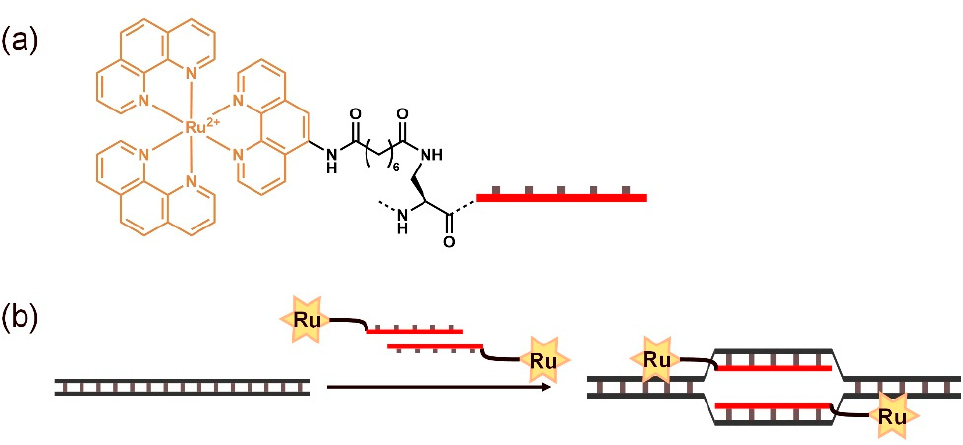
Figure 8. ( a ) Structure of Ru-PNA utilizing L -2,3-diaminopropionic acid for introducing the Ru-complex. ( b ) Ru-PNAs stabilize double-duplex invasion.